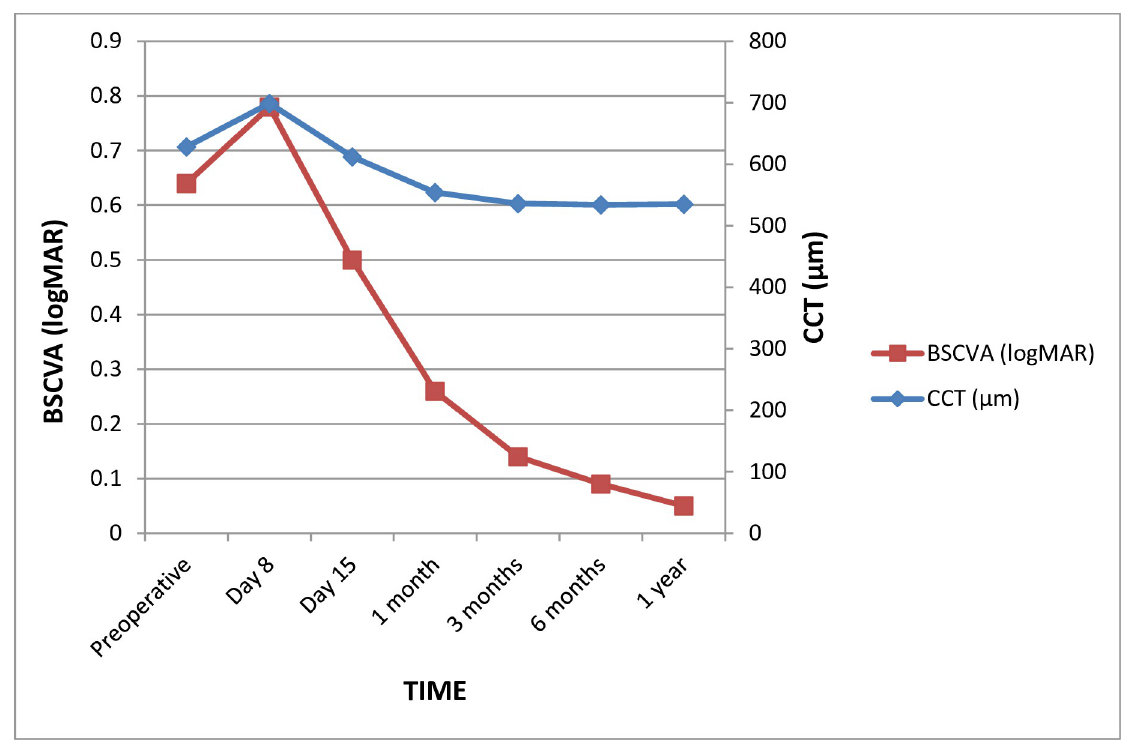
Fig 2. Change in BSCVA and CCT After DMEK. BSCVA, best spectacle-corrected visual acuity; CCT, central corneal